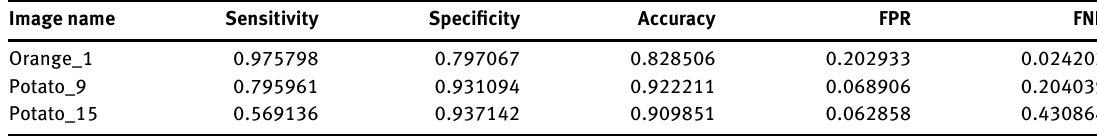
Table 1: Sensitivity, Specificity, Accuracy, FPR, and FNR Values for the Segmentation Result for Different Food Images. Image